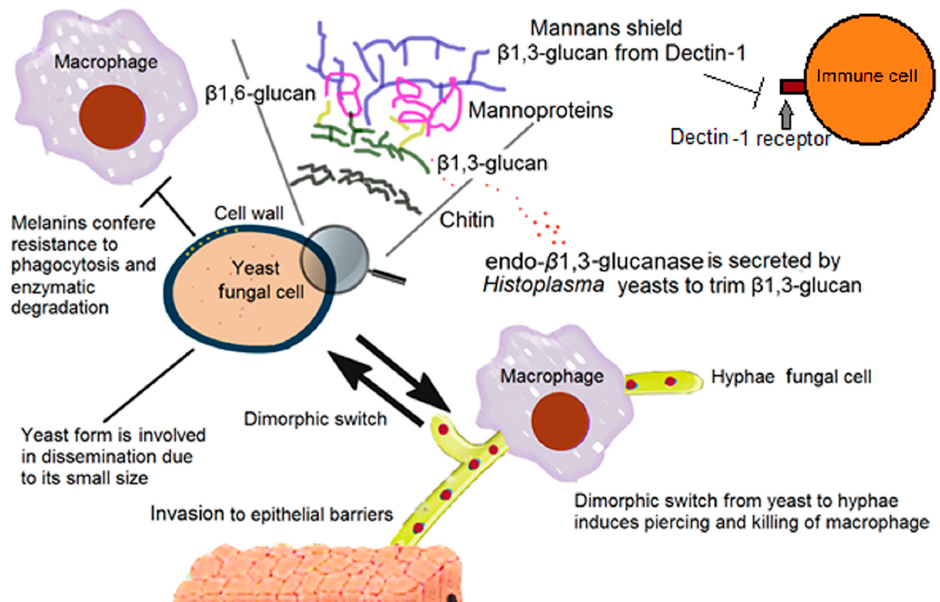
Figure 1. Components of the cell wall that help fungi to evade the immune system. The outer layer of mannans of many fungal cells shields the highly immunogenic β -1,3-glucan from Dectin-1 receptor, precluding the activation of effector mechanisms in immune cells. In the case of Histoplasma cells, endo- β -1,3-glucanase is released to trim β -1,3-glucans from the cell and prevents its recognition via Dectin-1 receptor. Melanin is distributed into the cell wall of some fungal pathogens and contributes to resistance to phagocytosis and enzymatic degradation by macrophages. Finally, the reversible, dimorphic switch between yeast and hyphae confers special traits to each form that helps the pathogen to disseminate and invade the